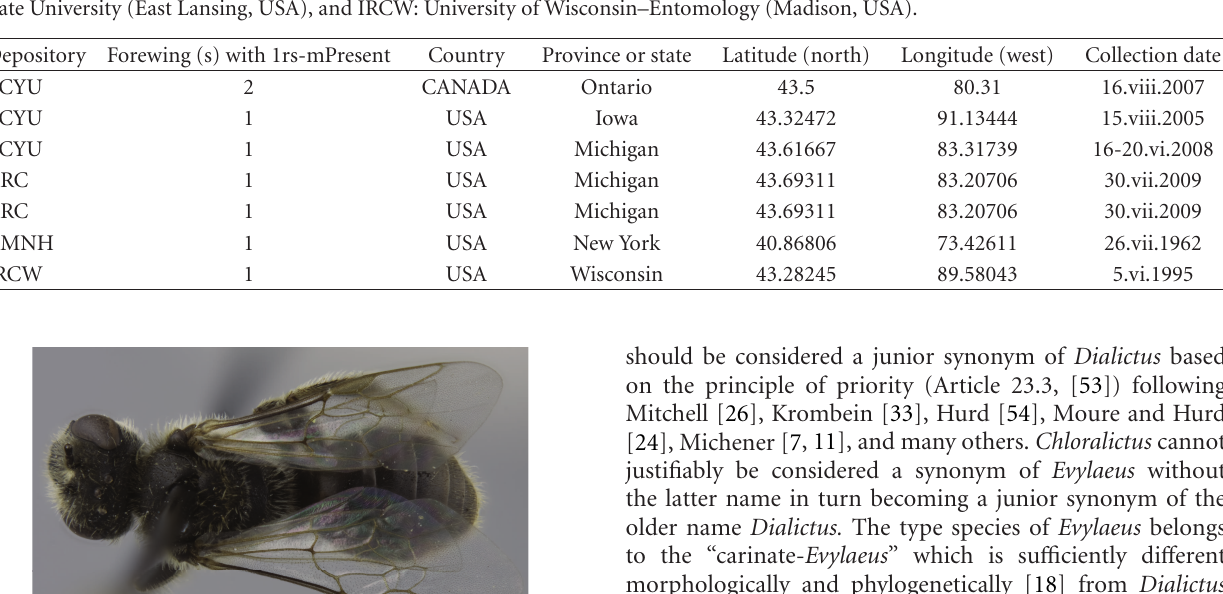
Table 2: Lasioglossum anomalum individuals with vein 1rs-m present. PCYU: Laurence Packer’s Collection, York University (Toronto, Canada), AMNH: American Museum of Natural History (New York, USA), ARC: Albert J. Cook Arthropod Research Collection, Michigan